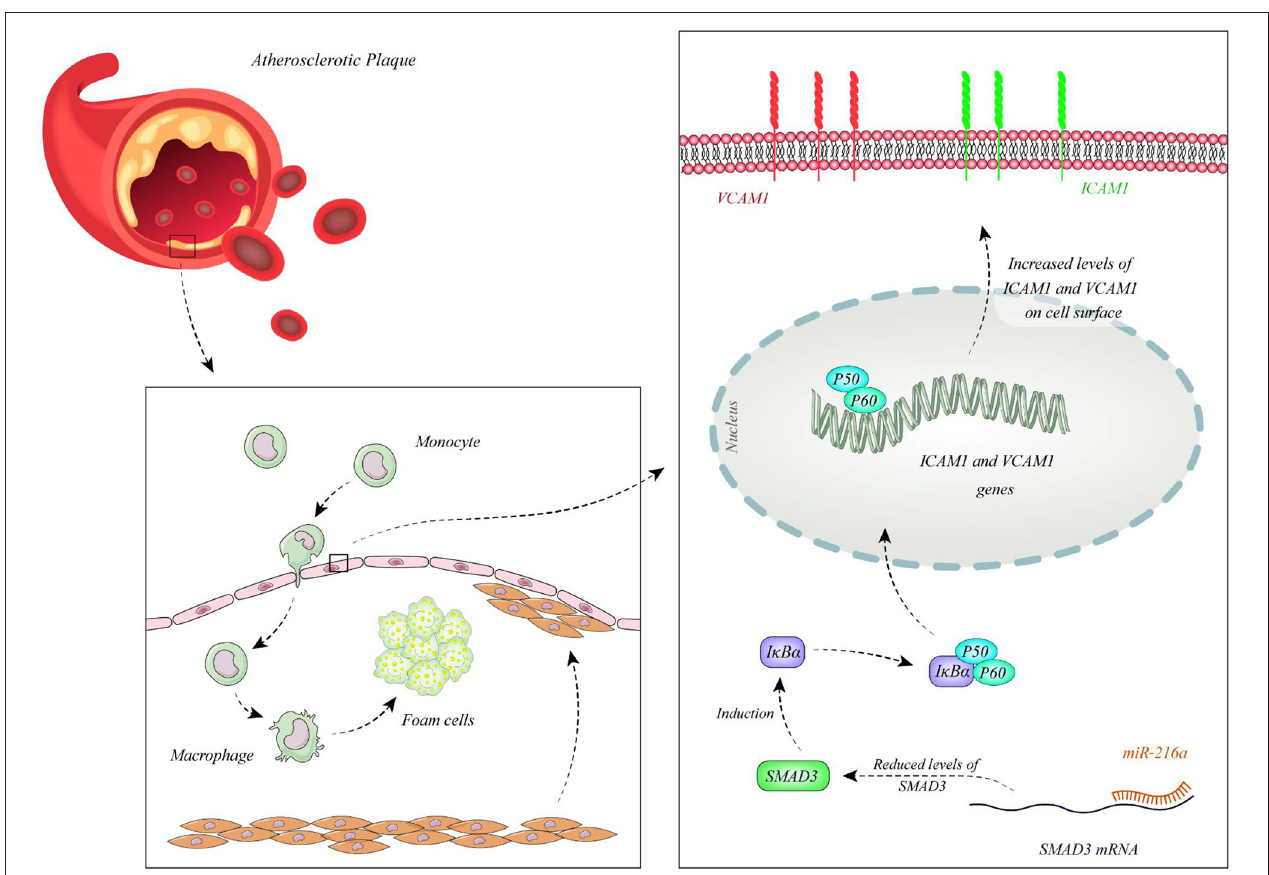
FIGURE 1 | miR-216a is over-expressed in CAD patients. miR-216a attaches to 3’ UTR of Smad3 and decreases its levels. Down-regulation of Smad3 leads to reduction of I κ B α releasing NF- κ B and enhancing its nuclear transport. Subsequent up-regulation of ICAM1 and VCAM1 enhances attachment of monocytes to endothelial cells promoting development of CAD